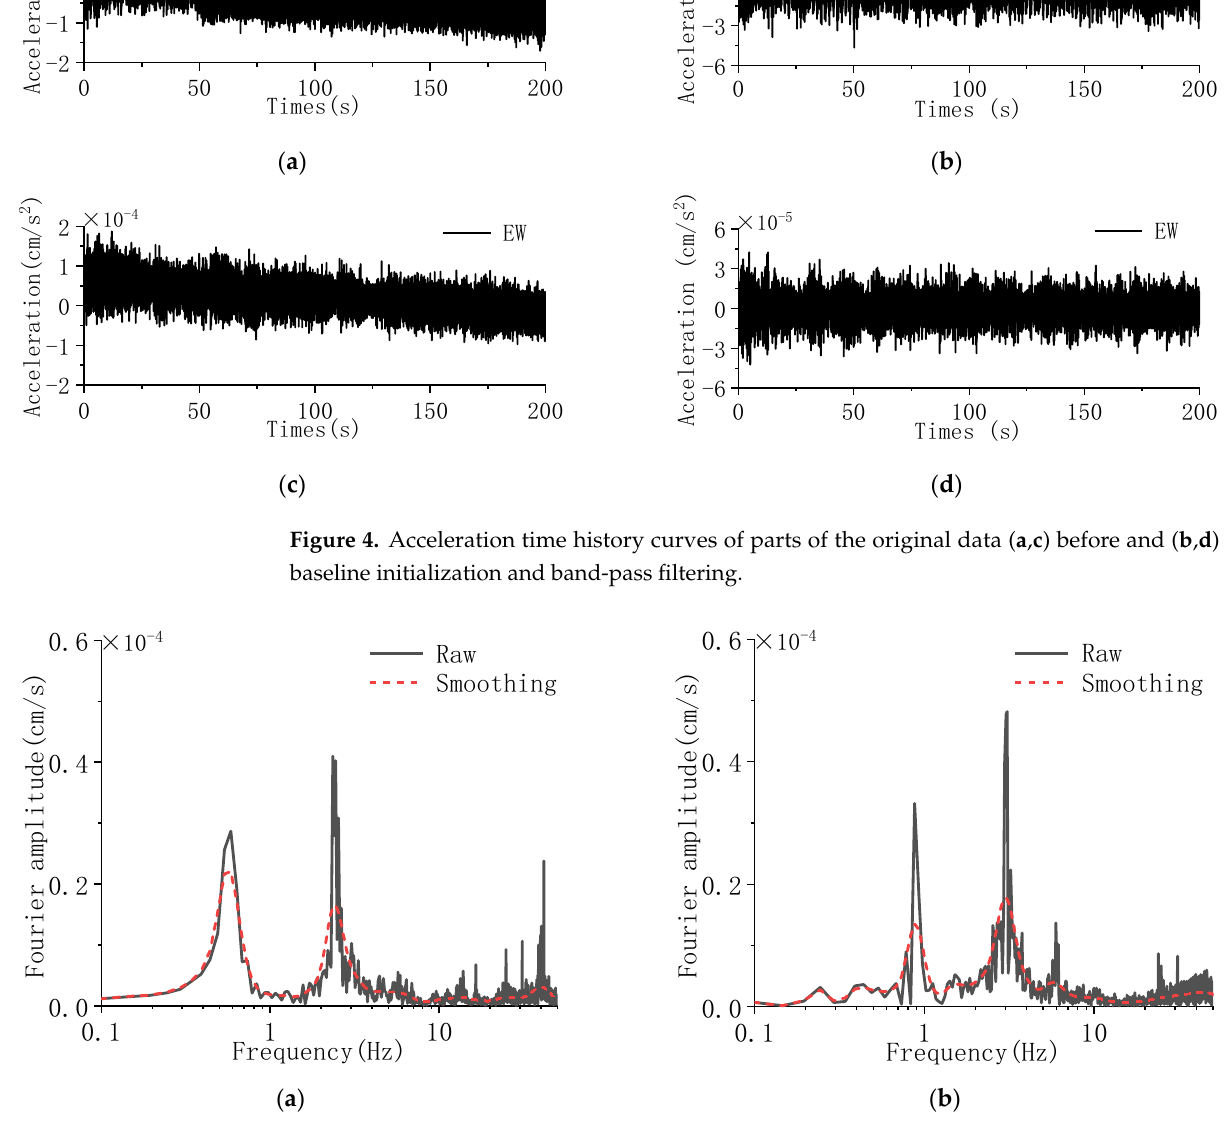
Figure 5. Fourier amplitude spectra of several segments of data, with and without smoothing ( a ) NS; ( b ) EW.